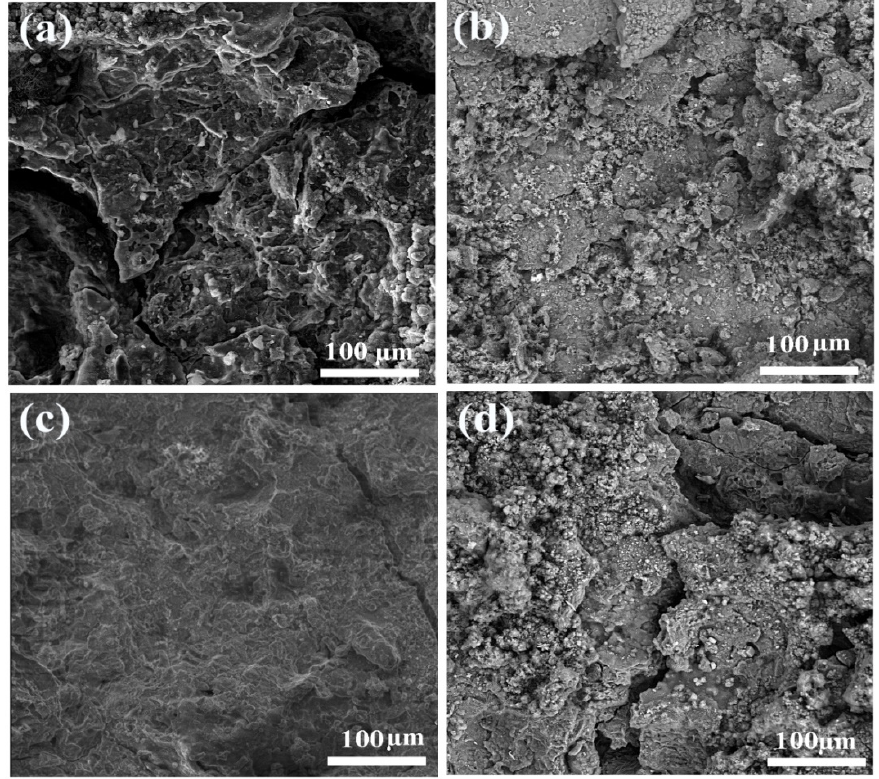
Figure 9. Surface morphology of the ( a ) MZ, ( b ) MC1, ( c ) MC2, ( d ) MC3 composites after being immersed in SBF for 7 days.